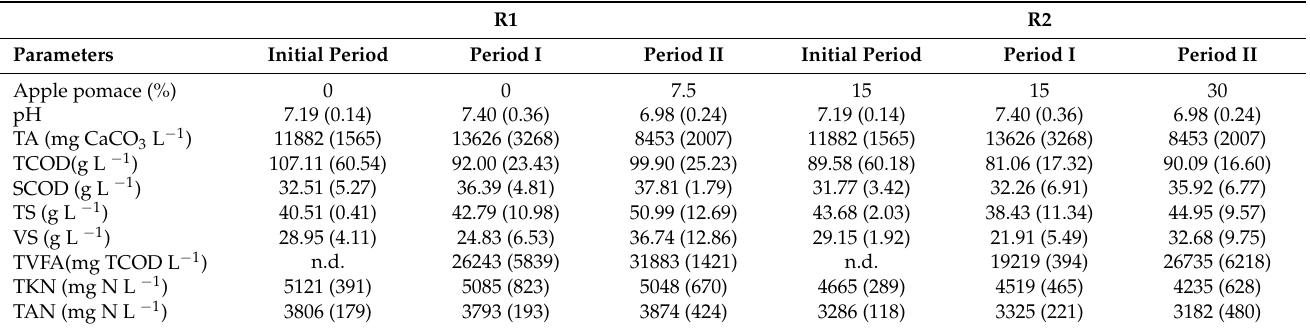
Figure 2. The pH and IA/PA ratio evolution for both reactors during the semi-continuous AD operation. In period I (27–138 days), R1 was used to digest SM alone; whereas R2 was used to co-digest SM with AP in a feed VS ratio of 85.0% SM and 15.0% AP. In period II (139–240 days), R1 was fed with a mixture of SM and AP in a feed VS ratio of 92.5% SM and 7.5% AP, and R2 was fed with a mixture composed of 70.0% SM and 30.0% AP on a VS basis. Table 1 shows the chemical composition of the influents for R1 and R2 for both periods. Table 1. Composition of feedstocks at different mixture ratios. Standard deviations are shown in parenthesis. No significant differences were found among the analytical values ( p > 0.05).